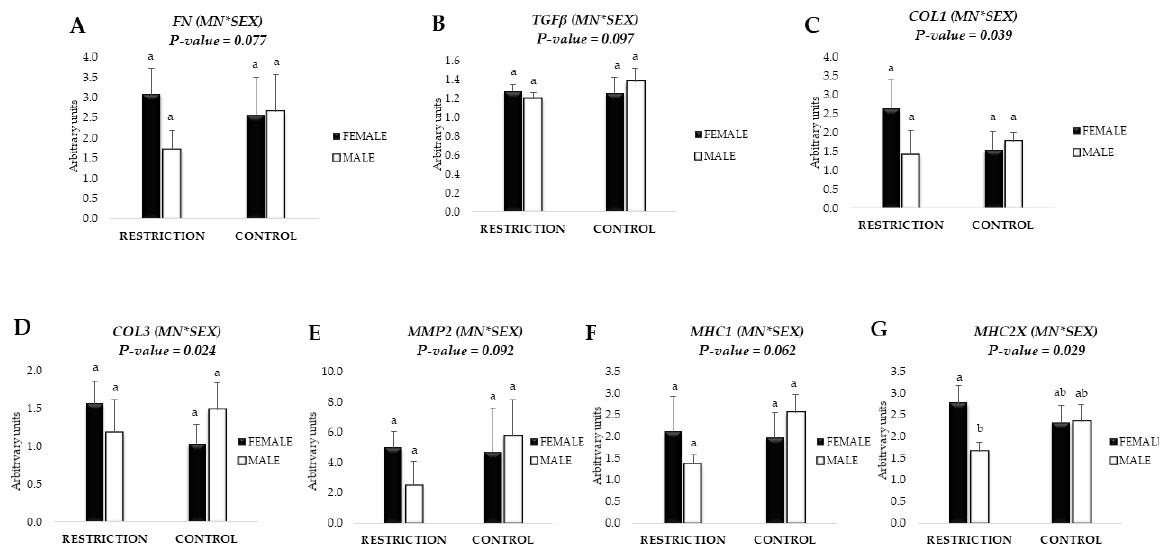
Figure 3. Interaction effect between maternal treatment (CON vs. RES) and offspring’s sex (FEMALE vs. MALE) on the relative gene expression of FN ( A ), TGF β ( B ), COL1 ( C ), COL3 ( D ), and MMP2 ( E ), MHC1 ( F ), and MHC2X ( G ) at 450d. Different letters indicate differences among groups. Tendency was considered when 0.10 < p > 0.05 and significant differences when p <